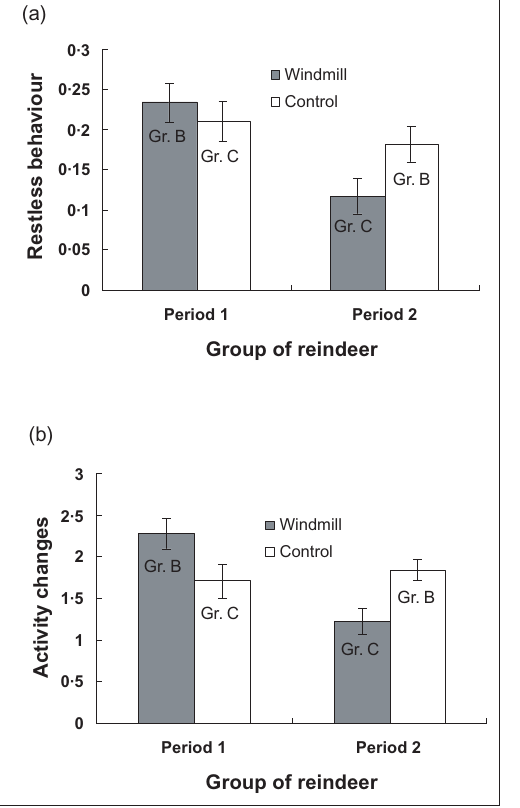
Fig. 5. The frequency (min -1 ) of activity changes (a) in relation to enclosure and reindeer group, and the proportion of restless behaviour (b) in relation to enclosure and rotor movement for period 3 and 4 in 2000. Bars: standard error of the